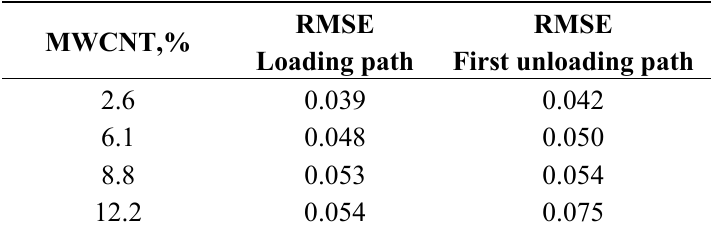
Table 3. RMSE at different percents of weight volume fractions of MWCNTs for loading and the first unloading paths.